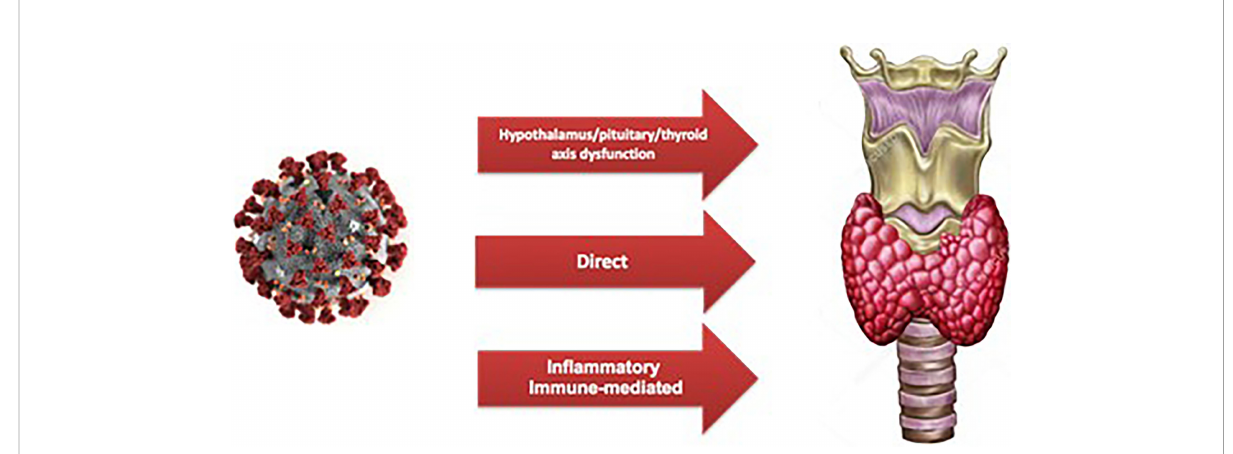
FIGURE 2 Representation of mechanisms of damage of SARS-CoV-2 to the thyroid